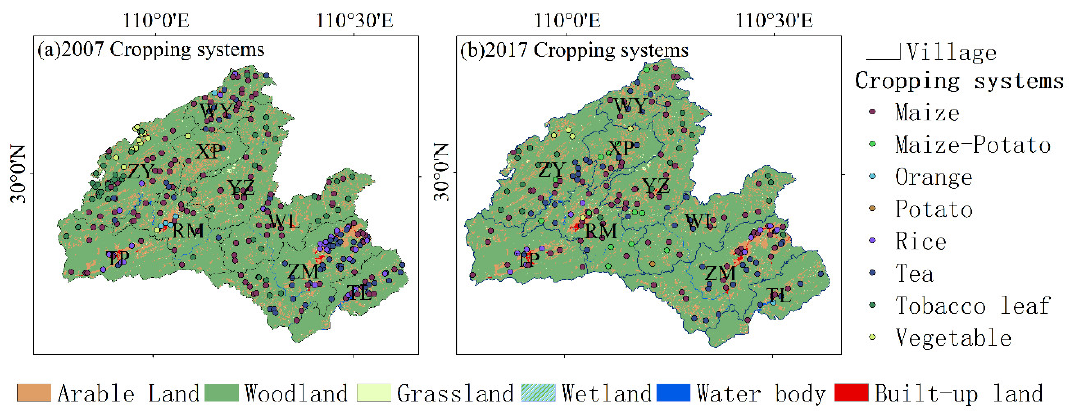
Figure 2. Cropping system distribution maps of the study area in ( a ) 2007 and ( b ) 2017.